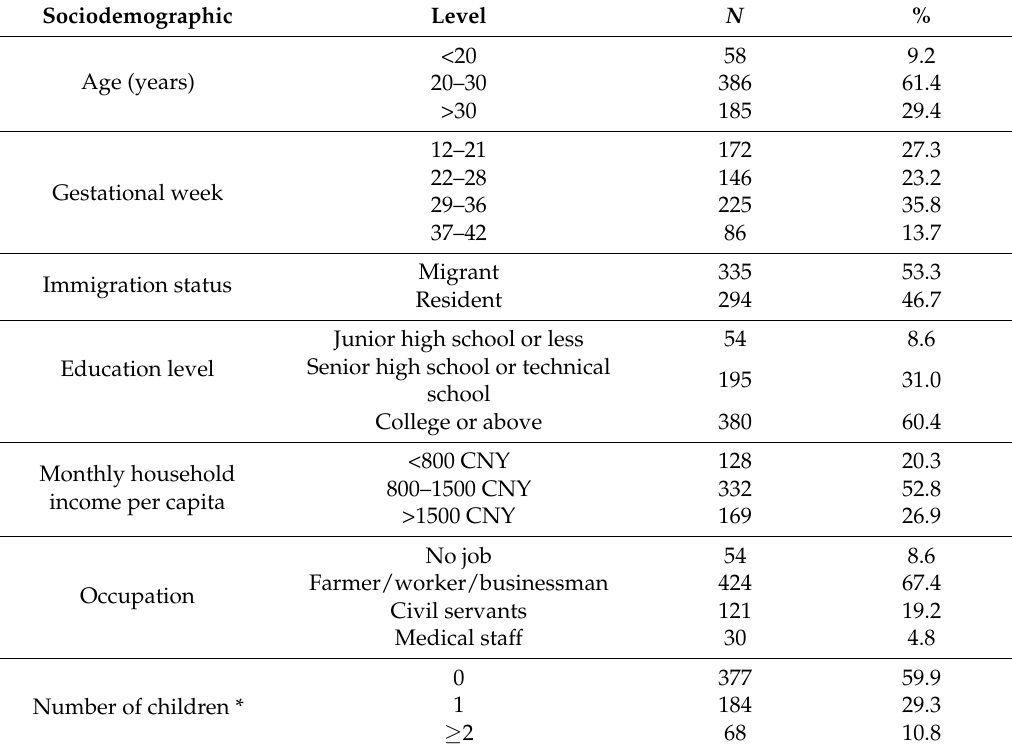
Table 1. The socio-demographic information of the participants in this study ( N =